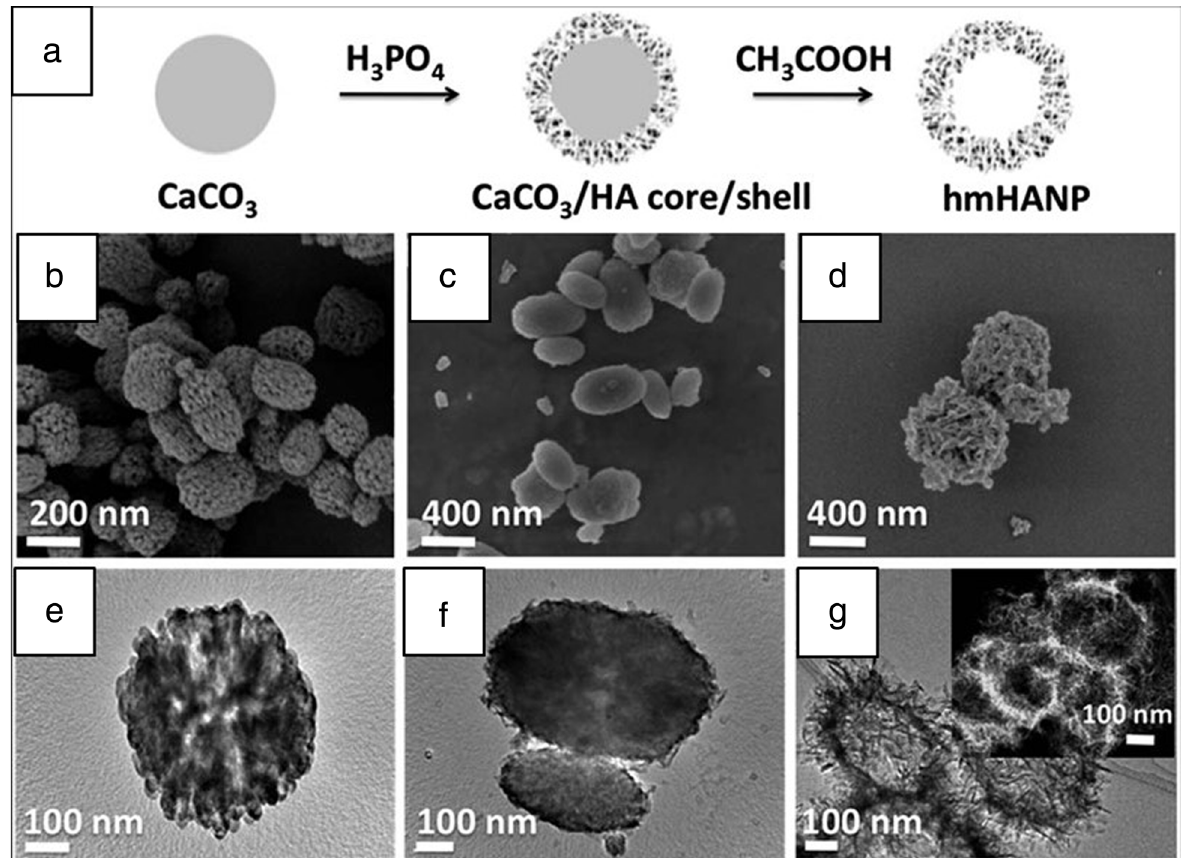
Figure 3: ( a ) An illustration indicating the synthetic process of hmHANP. SEM images of ( b ) CaCO 3 nanoparticles, ( c ) CaCO 3 /HA core/shell nanocomposites, ( d ) hmHANP; TEM images of ( e ) CaCO 3 nanoparticles, ( f ) CaCO 3 /HA core/shell nanocomposites, ( g ) hmHANP ( inset: dark - fi eld STEM image ) [ 50 ] .